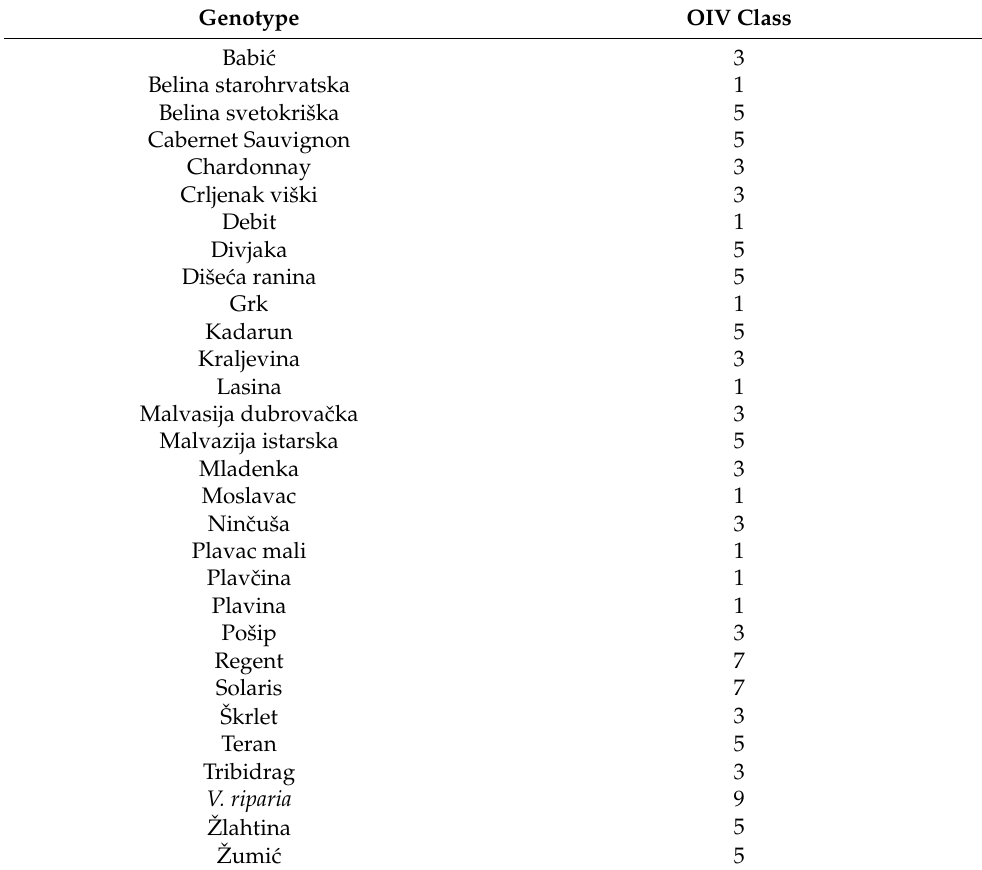
Table 1. Genotypes and their corresponding OIV classes 1, 3, 5, 7, and 9 from the most abundant to the totally absent sporulation.